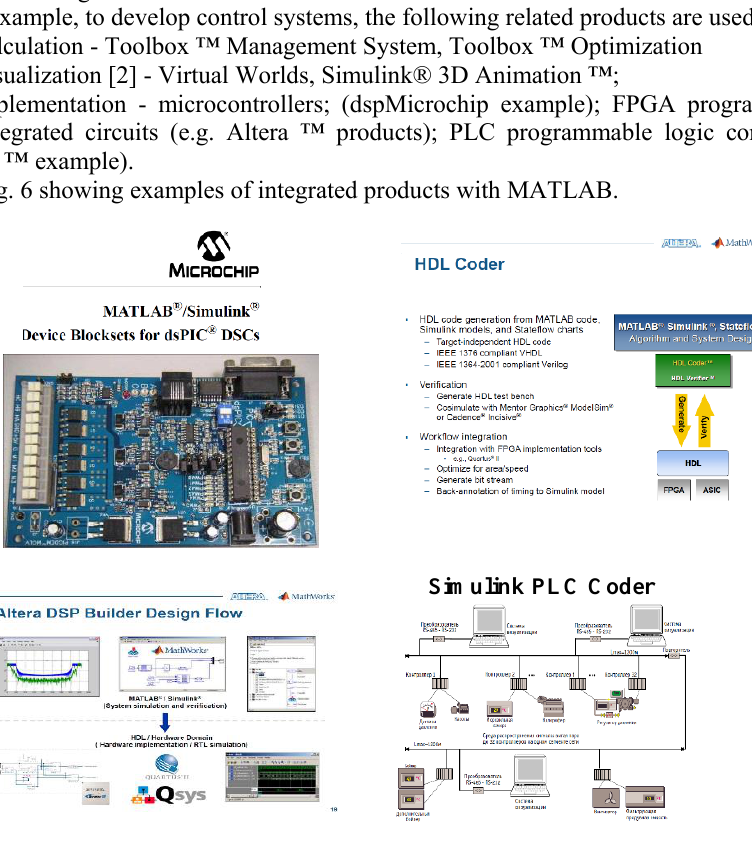
Fig. 6. Examples of integrated products with